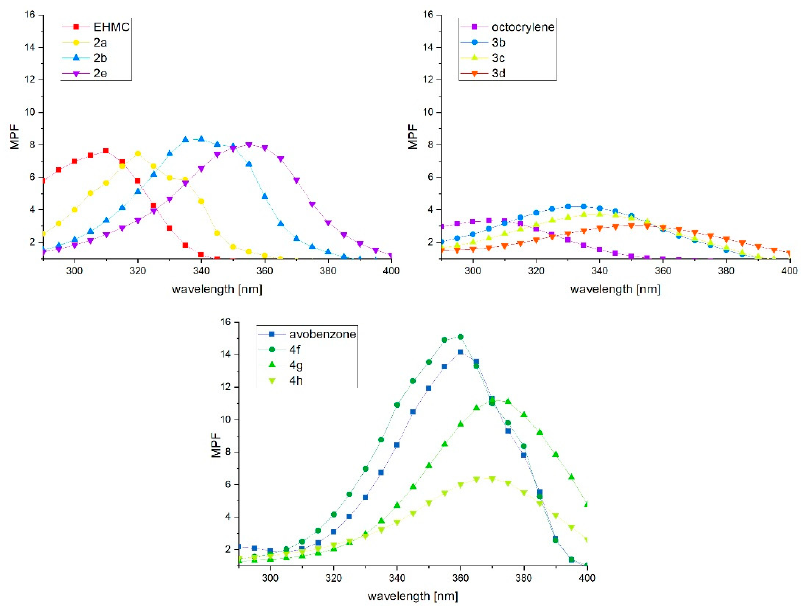
Figure 4. UV absorption spectra of tested compounds and reference UV filters obtained in macrogol formulation at 2% ( w / w ) concentration applied on polymethylmethacrylate plates. MPF–Monochromatic Protection